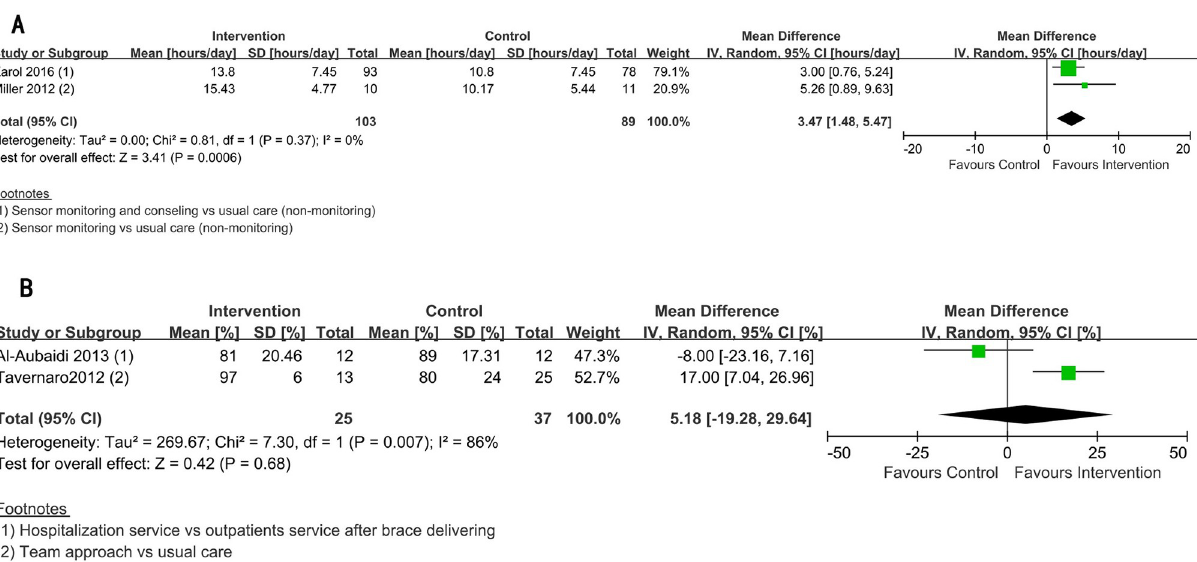
PLOS ONE | https://doi.org/10.1371/journal.pone.0271612 July 20,